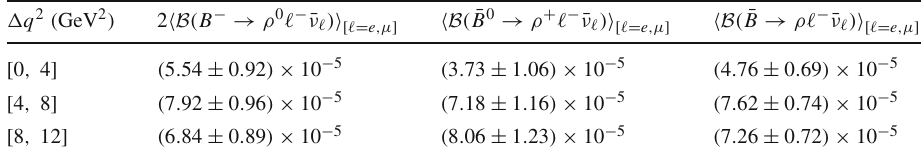
(cid:14) q 2 ( GeV 2